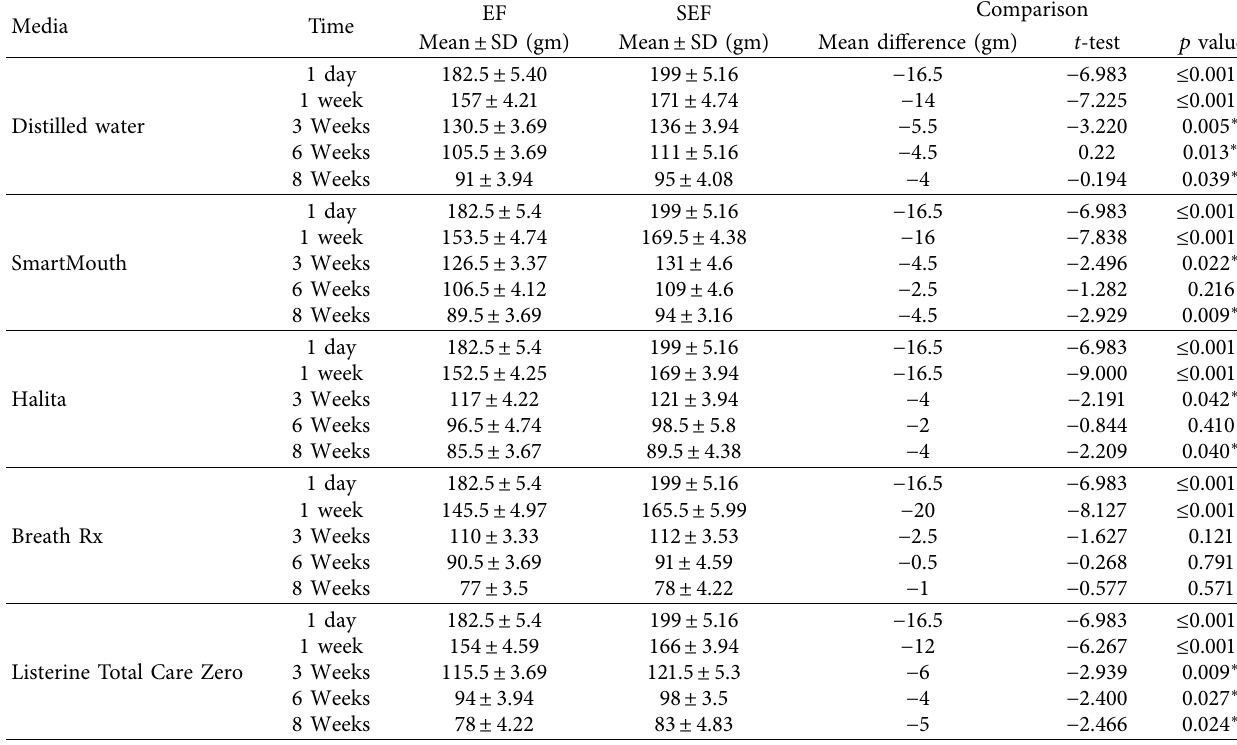
Table 5: Descriptive statistics and comparison of the force level between Elasto-Force and Super Elasto-Force elastomeric